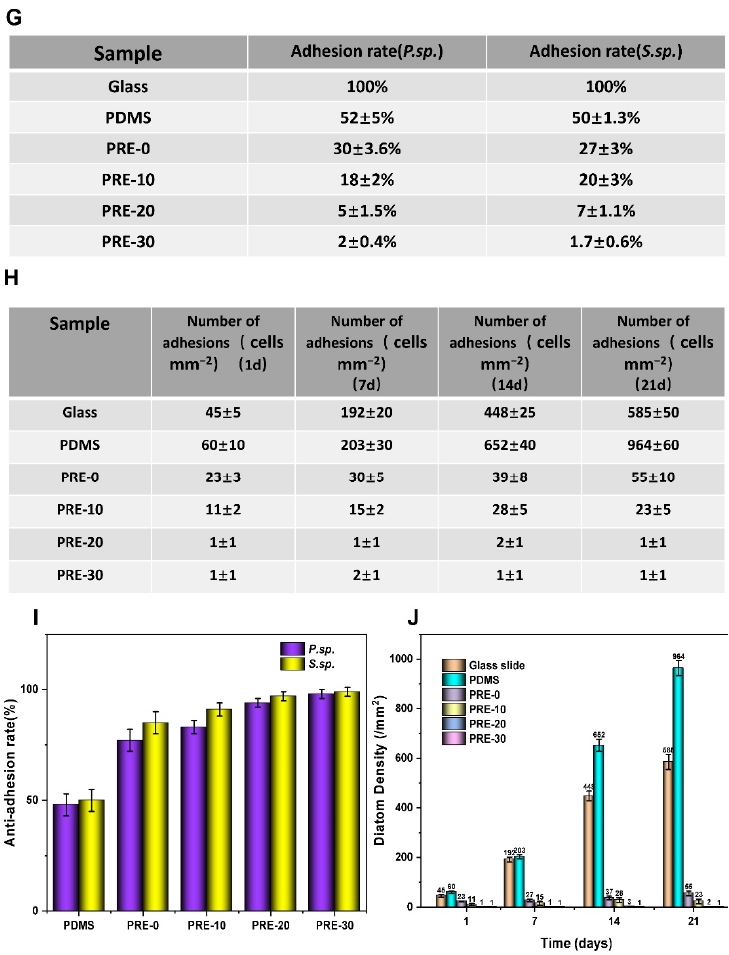
Figure 4. Antibacterial and anti-silica properties of PRE polymers. ( A ) Fluorescence images of Pseudomonas sp. (legend is 50 µ m). ( B ) Fluorescence images of Shewanella sp. (legend is 50 µ m). ( C – F ) Fluorescence images of N. incerta adhesion after 1, 7, 14 and 21 days to (a) glass, (b) PDMS, (c) PRE-0, (d) PRE-10, (e) PRE-20 and (f) PRE-30 fluorescence images (legend for 100 µ m). ( G ) Adhesion rates of P. sp. and S. sp. ( H ) The number of N. incerta settling on the coating surface at different days ( I ) Adhesion rates of Pseudomonas sp. and Shewanella sp. ( J ) Quantitative sedimentation density of N. incerta on the coating